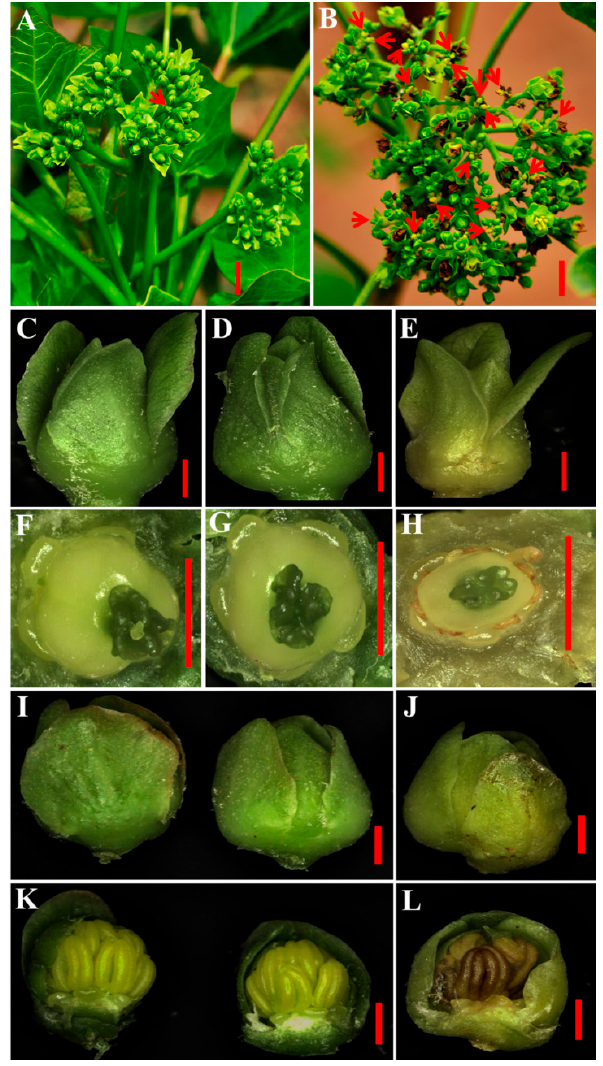
Figure 7. Abortion of florets in transgenic Jatropha plants. ( A , B ) Inflorescences of the wild type (WT) and transgenic line L10, respectively. The red arrow refers to the normal floret in ( A ) or the abnormal florets in ( B ). ( C , D ) Normal female flowers of WT and transgenic L10 Jatropha , respectively. ( E ) Abortive female flowers of transgenic L10 Jatropha . ( F − H ) Anatomy of female flowers from ( C − E ). ( I ) Normal male flowers in the WT (left) and transgenic Jatropha L10 (right). ( J ) Abortive male flowers of the transgenic Jatropha L10. ( K , L ) Anatomy of the male flowers from ( I , J ), respectively. Bar s = 1.0 cm shown in ( A , B ); bars = 1.0 mm shown in ( C − L ).